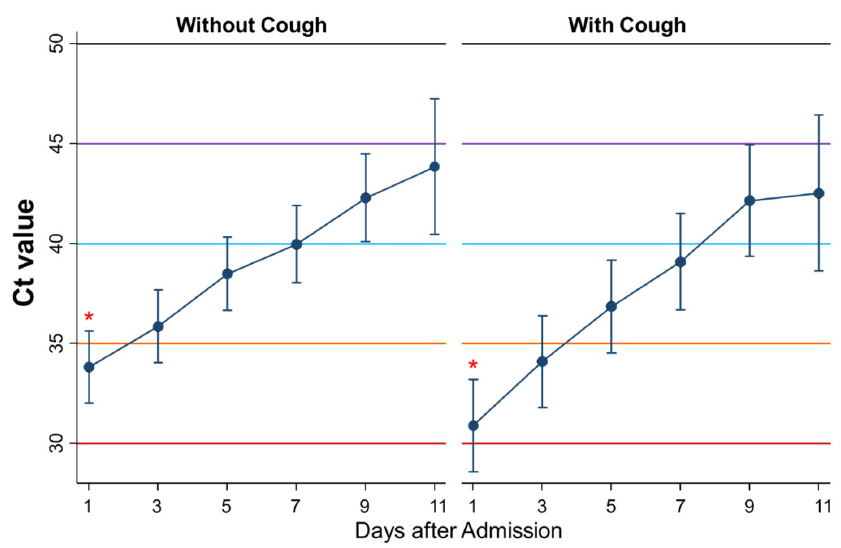
Figure 6. Differential kinetics of Ct values between patients without and with cough. Mean Ct with 95% confidence intervals. When the Ct value is 40 or more, the PCR test result is considered negative. * represents a significant difference ( p < 0.05).